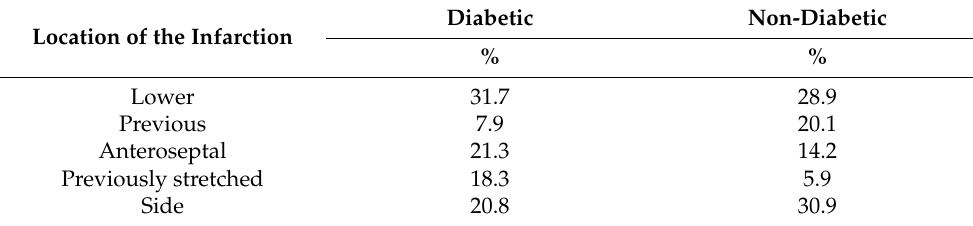
Table 3. Distribution of cases according to the location of myocardial